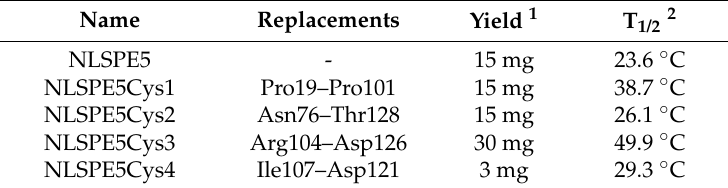
Table 1. Yield of purified ND-RNase carrying five disulfide bonds and their T 1/2 calculated using